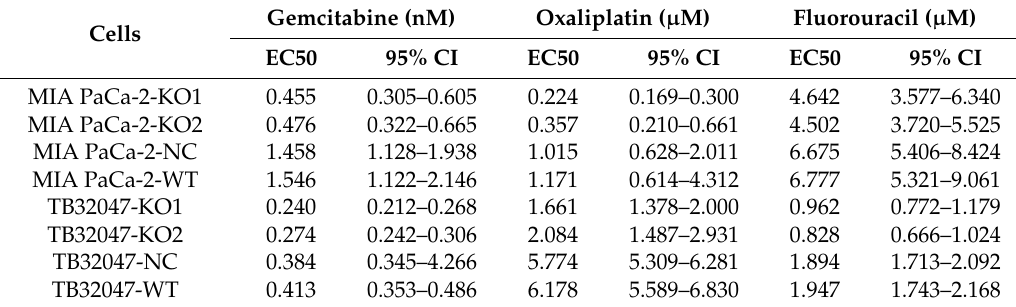
Table 2. The EC50 values and 95% CI (Confidence Interval) of chemotherapy drugs in